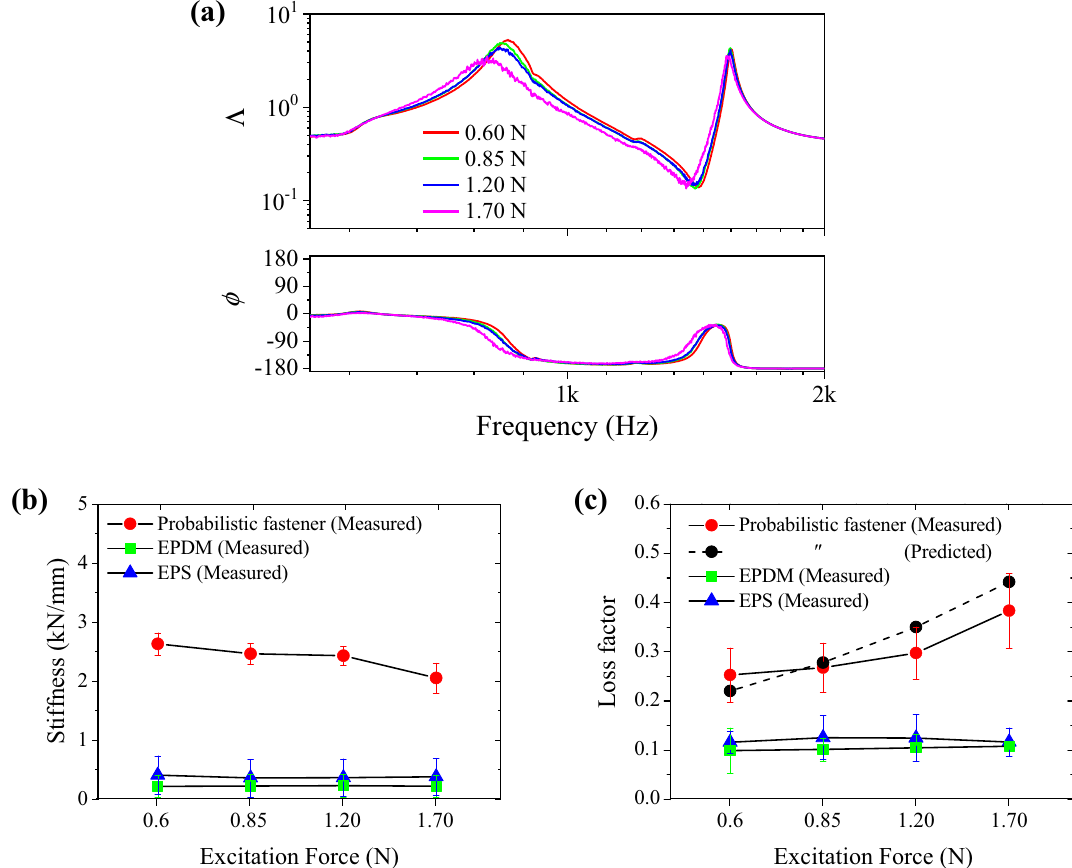
Figure 7. Effect of excitation magnitude on the vibration response with. ( a ) Measured vibration response of the cantilever supported with the probabilistic fastener. Comparison of dynamic properties of the probabilistic fastener and the polymer materials: ( b ) stiffness and ( c ) loss